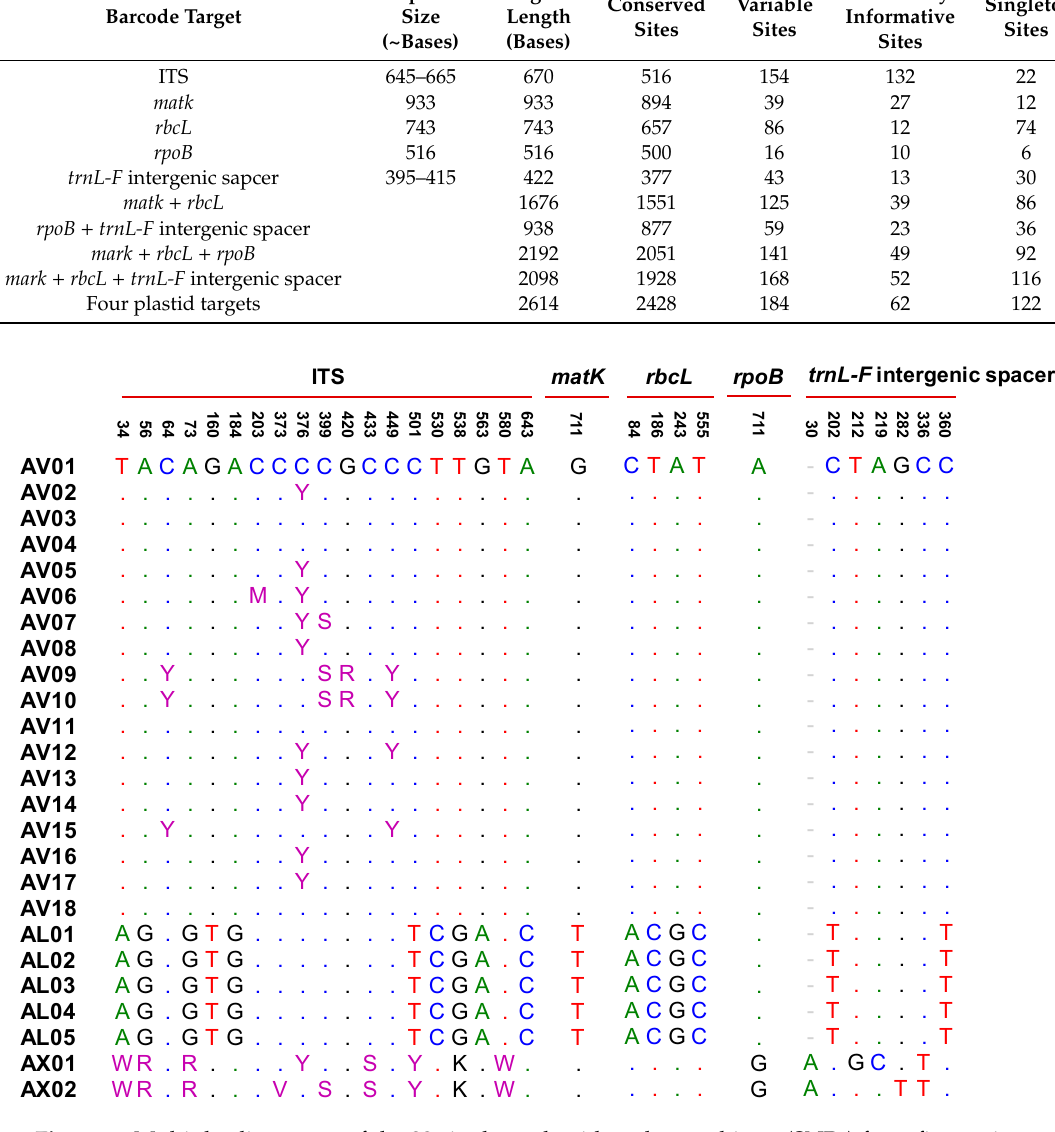
Figure 1. Multiple alignments of the 32 single nucleotide polymorphisms (SNPs) from five regions (ITS, matK, rbcL, rpoB, trnL-F intergenic spacer) in Amomi Fructus. Numbers above the bases indicate the position of single-nucleotide polymorphisms in each region. The dots indicate the consensus nucleotide; Sample code shown in Table 1. Heterozygous sites were defined according to IUPAC. AX01 ( A. villosum var. xanthioides ): KJ151892 and MH161417; AX02 ( A. villosum var. xanthioides ): KJ151893 and MN067432.